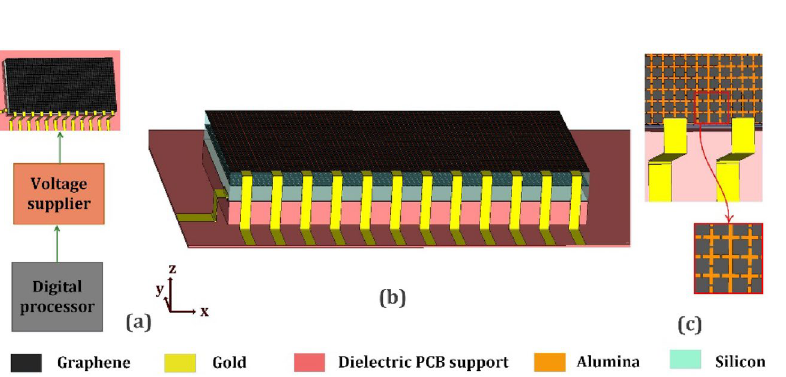
Figure 15. Schematic of reflectarray with bias circuit. ( a ) schematic of bias voltage program and supplier. ( b ) unit cell electrical connection in each cell cluster. ( c ) reflectarray